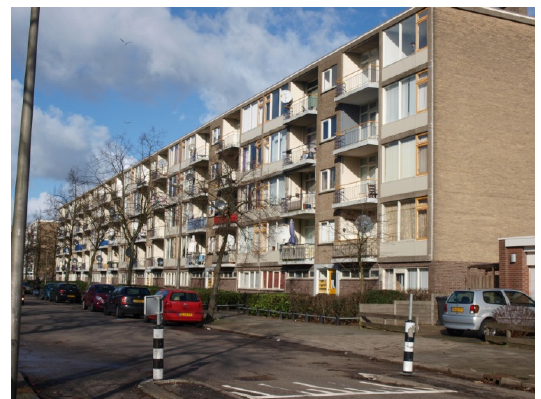
Figure 3. The case study building: a post-war apartment building in the Marco Pololaan in